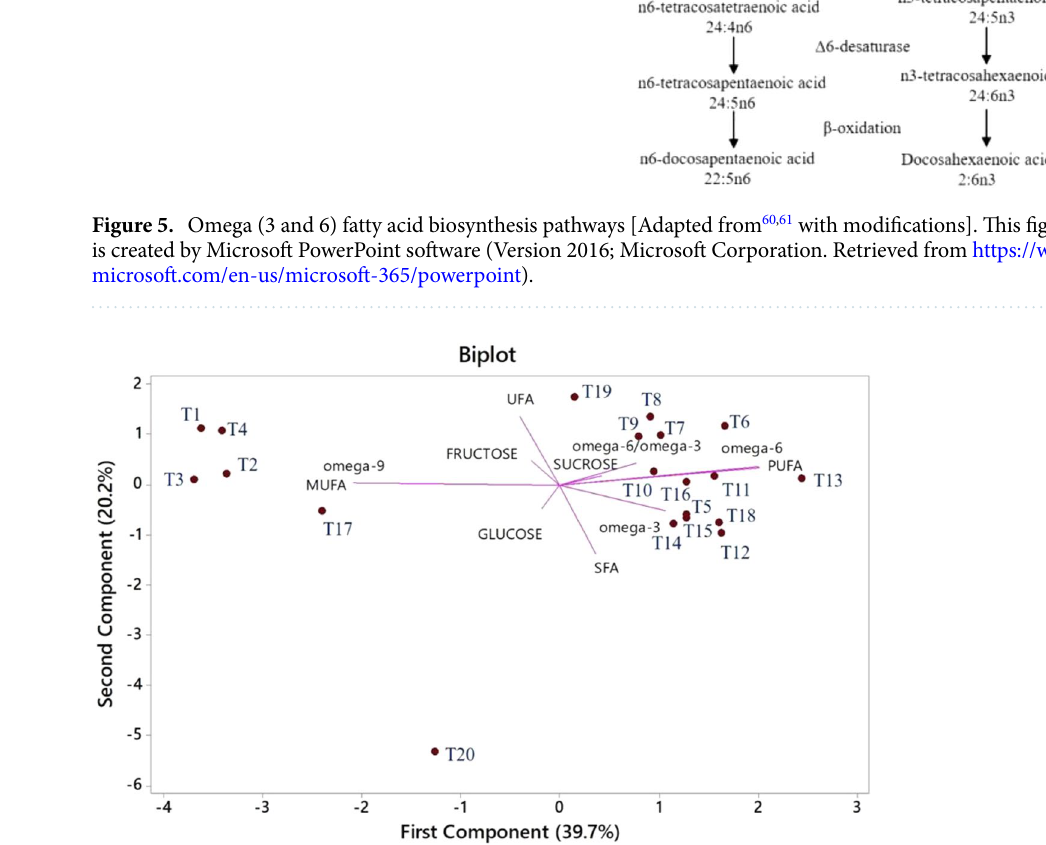
Figure 6. Principal component analysis of studied treatments on sugars and fatty acids of licorice. SFA saturated fatty acid, USFA unsaturated fatty acid, MUFA monounsaturated fatty acid, PUFA polyunsaturated fatty acid. *Treatments (T) are shown with numbers; 1: W 100 Si 0 F 0 ; 2: W 100 Si 1 F 0 ; 3: W 100 Si 0 F 1 ; 4: W 100 Si 1 F 1 ; 5: